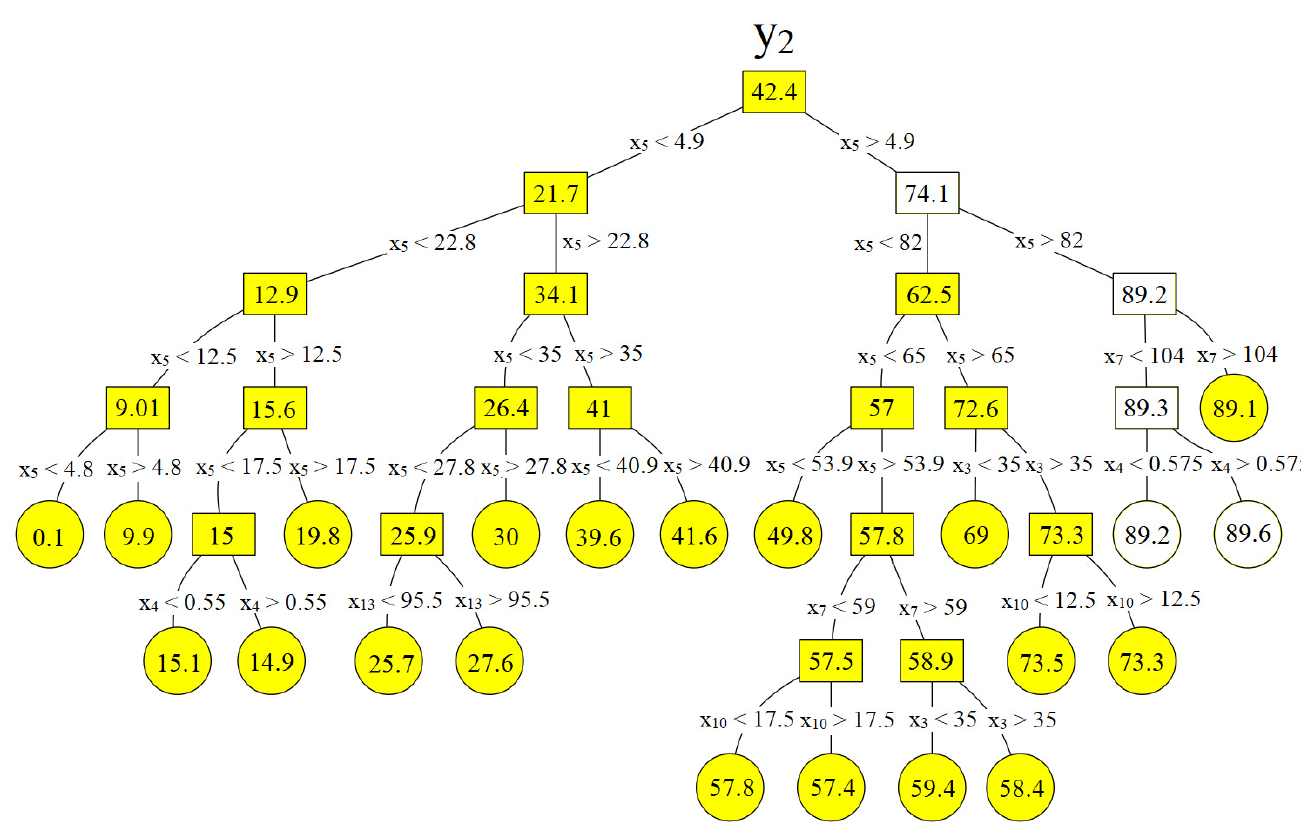
Figure 6. Regression tree analyzing the dependence of the crystal growth rate y 2 (mm/h) on the furnace design and process parameters x 1 –x 13 . The white-marked branches where leaf nodes have a maximum mean y 2 value are favorable. The RMSE for each split is given in Table A2 in Appendix A. Table 3. The most decisive inputs and their optimal values for the Cz-Ge growth with high growth rate y 2 , derived from RT analysis. The data ranges correspond to the white nodes in Figure 6.